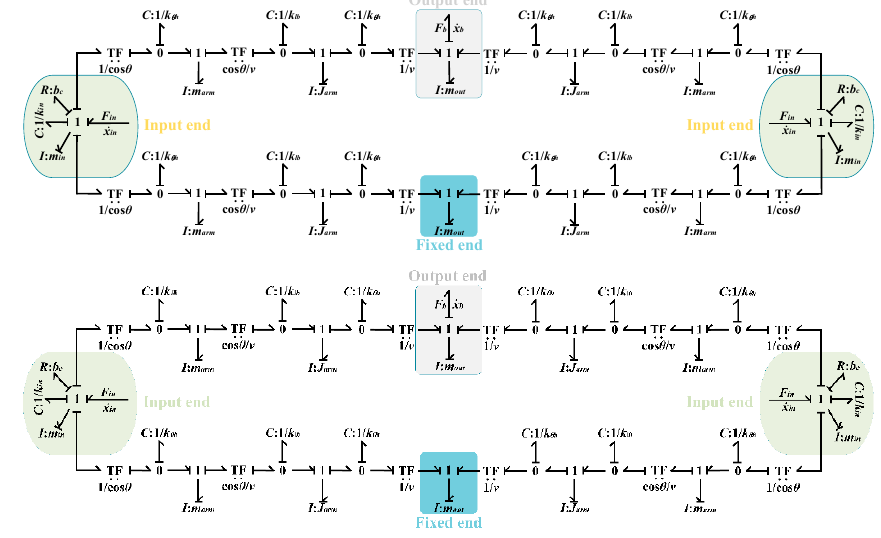
Figure 7. Bond graph model of the bridge ‐ type mechanism.